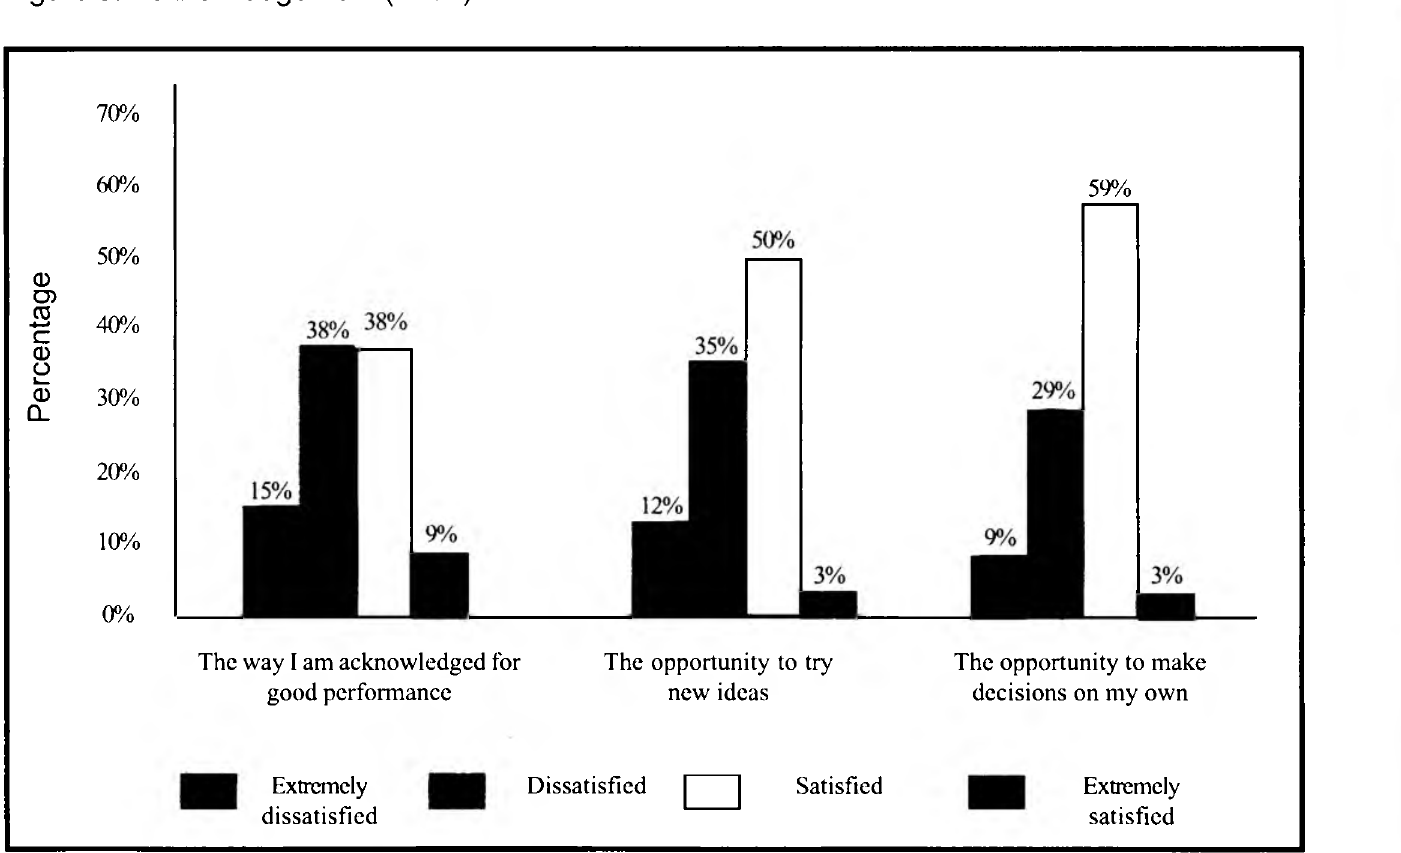
Figure 5: Acknowledgement